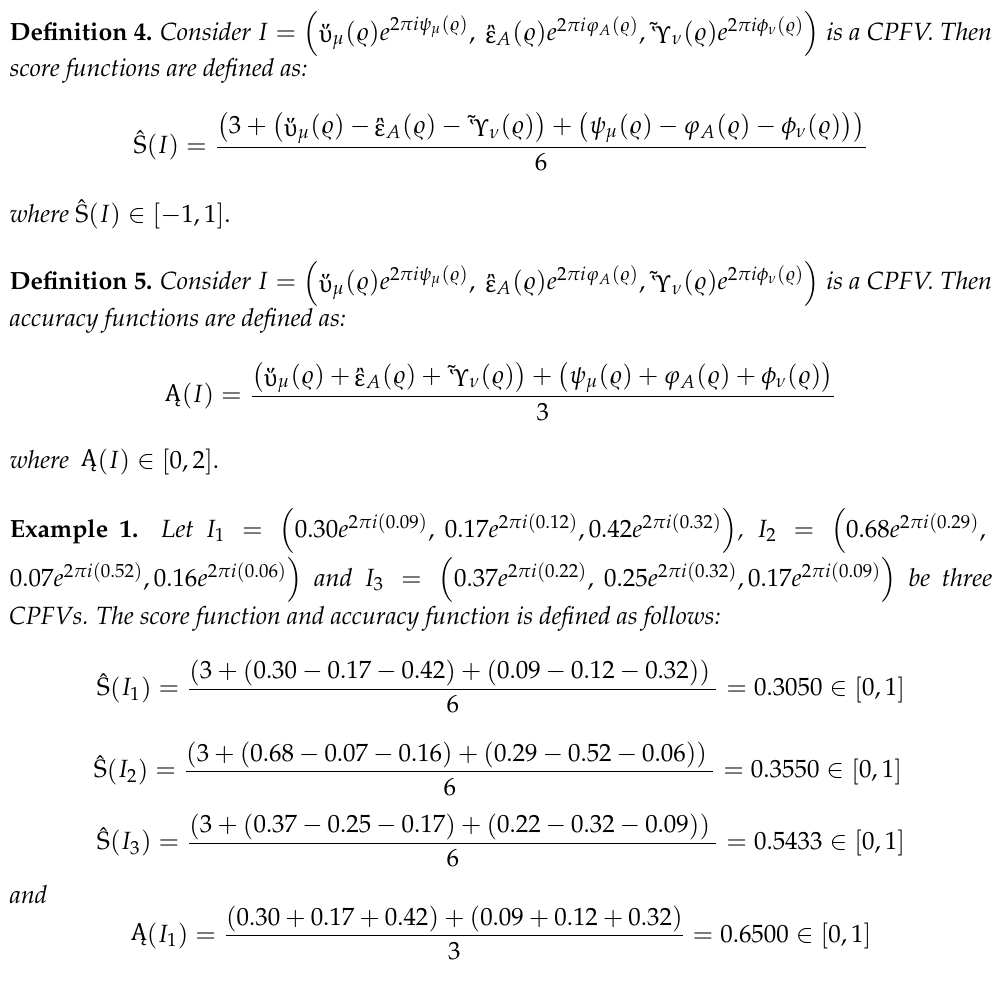
Table 1. Symbols and their meanings.